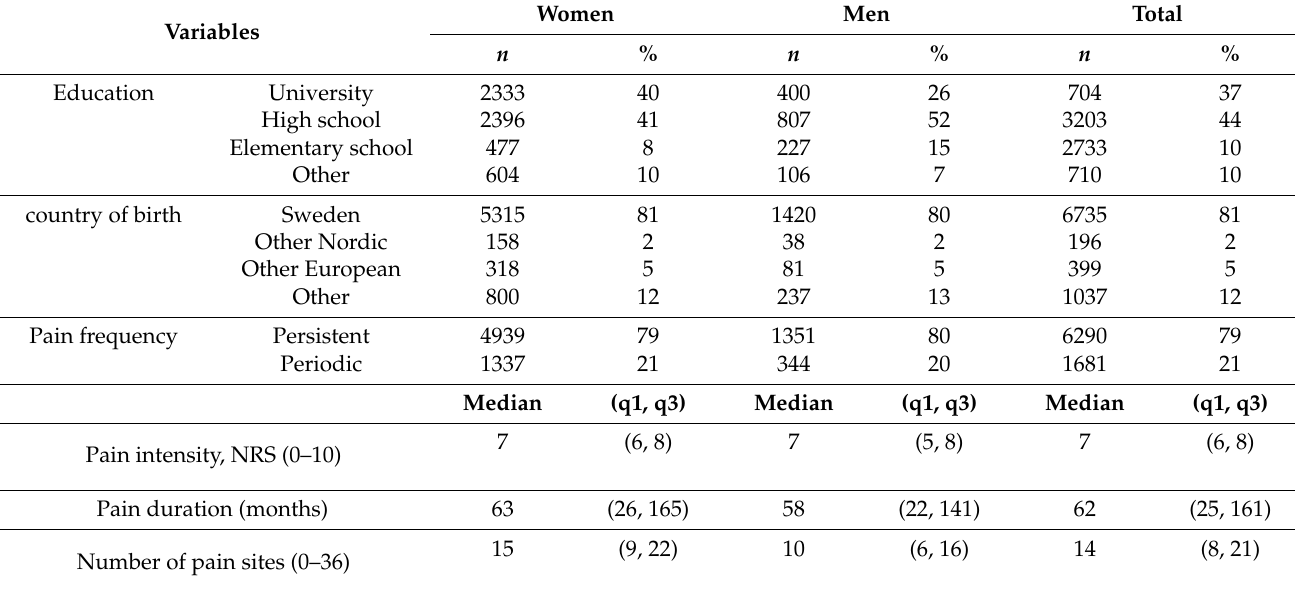
Table 1. Descriptive statistics on sociodemographic factors and pain characteristics in the study group at baseline ( n = 8515). Variables